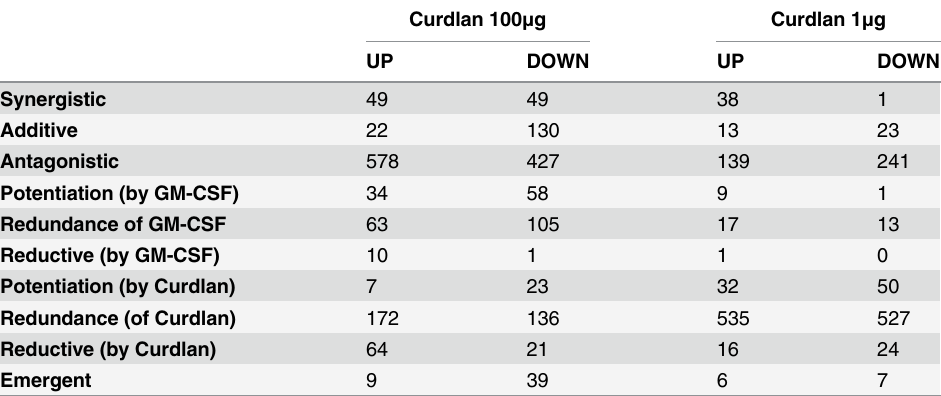
Table 4. Number of probe sets out of 45 101 found with a particular form of interplay between treat- ment with Curdlan (dose = 100 μ g or dose = 1 μ g), GM-CSF and their combination.